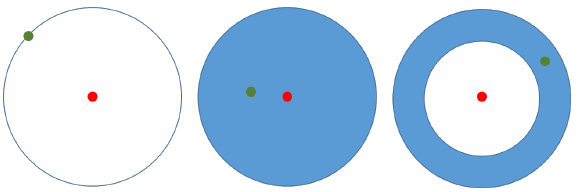
Figure 1: An example of geomasking methods, where the first from the left is a random directional and fixed radius masking way, the middle one is a random perturbation within a circle, and the last one represents donut masking.